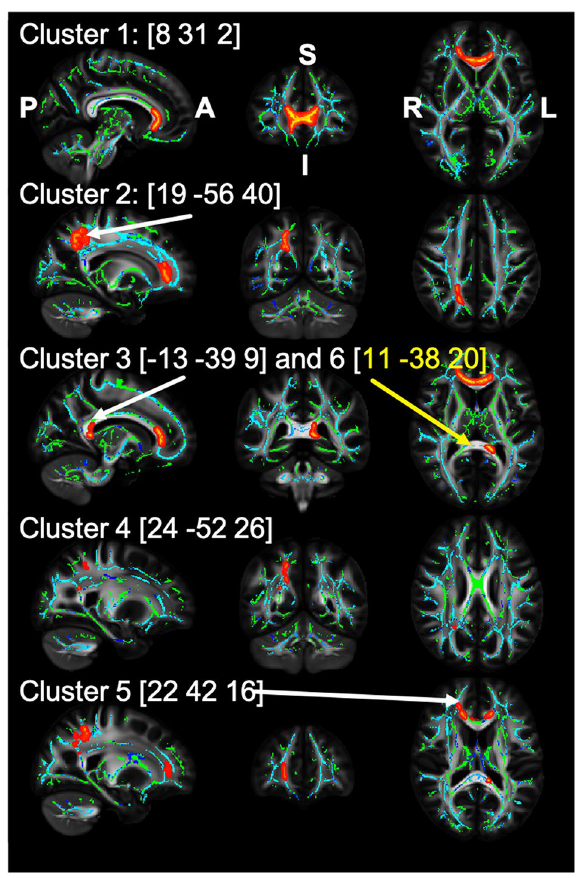
Figure 2. FA results for the interaction effect of group status (DE, HC) * IL-1β. Each row shows the sagittal, coronal, and axial views aligned with the coordinates of the respective cluster maximum (radiological display convention). Each slice consists of an FA template (grey), the mean FA skeleton of this study (green), overlaid by the age effect (blue; p FWE ≤ 0.05) and by the thickened threshold statistic with p FWE ≤ 0.05 (red-yellow), representing more positive slopes in the HC group. The clusters refer to the descriptions in Table 3: Cluster 1—Genu Corpus Callosum; Cluster 2—Superior longitudinal fasciculus L; Cluster 3 & 6—Splenium Corpus